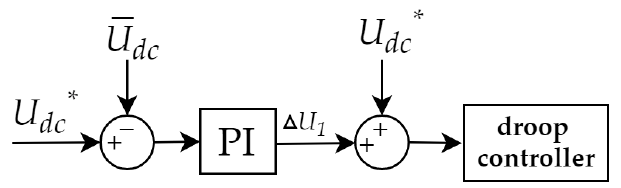
Figure 11. The voltage feed-forward control.